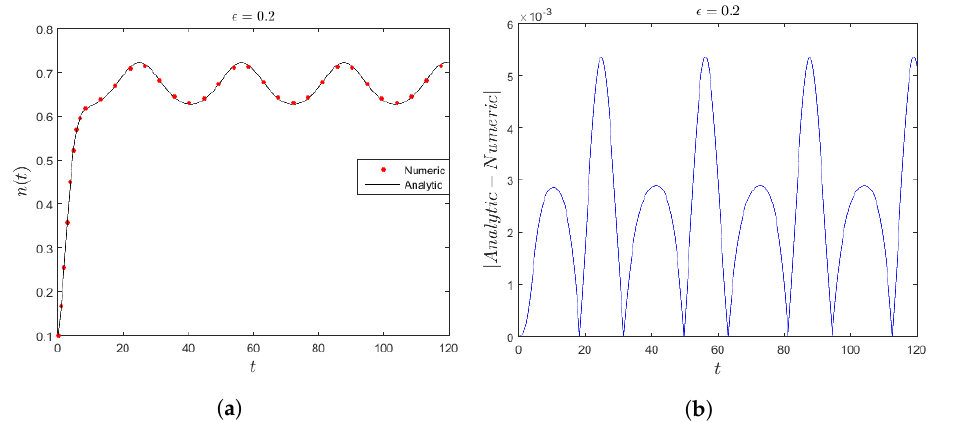
Figure 1. ( a ) The population evolution survives at the equilibrium state. The solid curve represents the analytic solution, given by (24), while the dotted curve represents the numerical solution, generated using the fourth-order Runge-Kutta technique. ( b ) The absolute difference between the numerical and analytic solution of (24), where κ = 1 + 0.1sin ( (cid:101) t ) , ρ = 1 + 0.17sin ( (cid:101) t ) , η = 1 + 0.5sin ( (cid:101) t ) , µ = 0.1, and σ = 0.33 < 1.